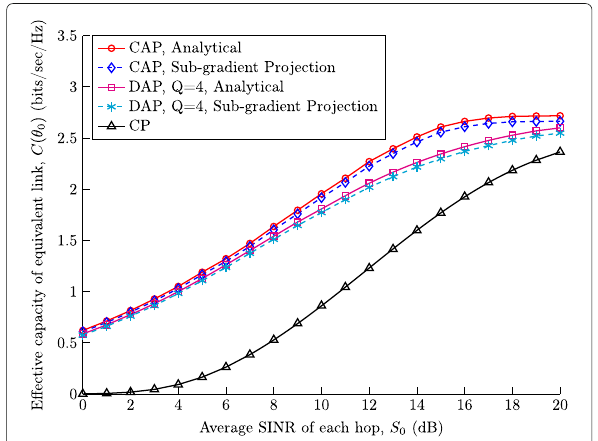
Fig. 3 Effective capacity versus number of relays, when path length is constant, path loss exponent ζ = 3, total average power consumption is fixed to 3 W/Hz, B 0 = 10 − 5 , θ 0 = 0.1 and Nakagami-m fading channels with m i = 2, 0 ≤ i ≤ N −